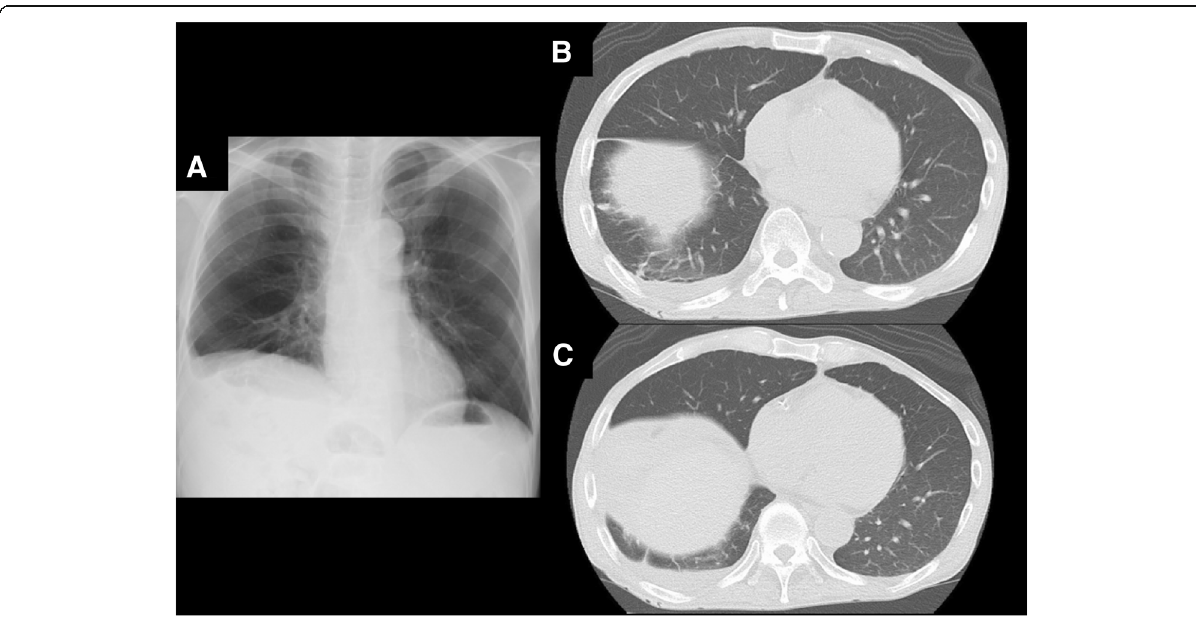
Fig. 4 Postoperative chest X-ray and computed tomographic (CT) images taken at 3 months after surgery. a Chest X-ray showed the expansion of the right lung. b , c CT images showed that no cyst existed in the bottom of the right